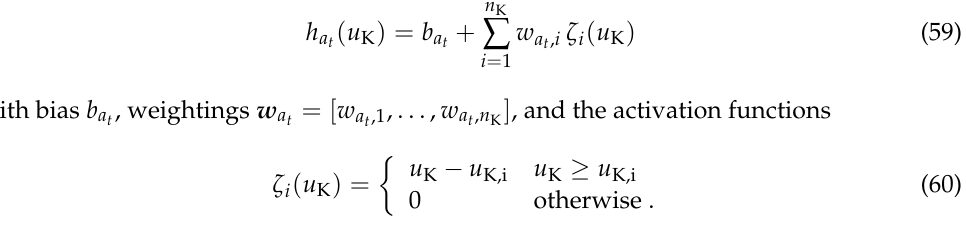
Figure 11. Starting with normal vector ξ reached by a sufficient kick intensity. The goal is to find the optimal kick intensity to reach ξ ∗ n , which is closest to the reference ξ r